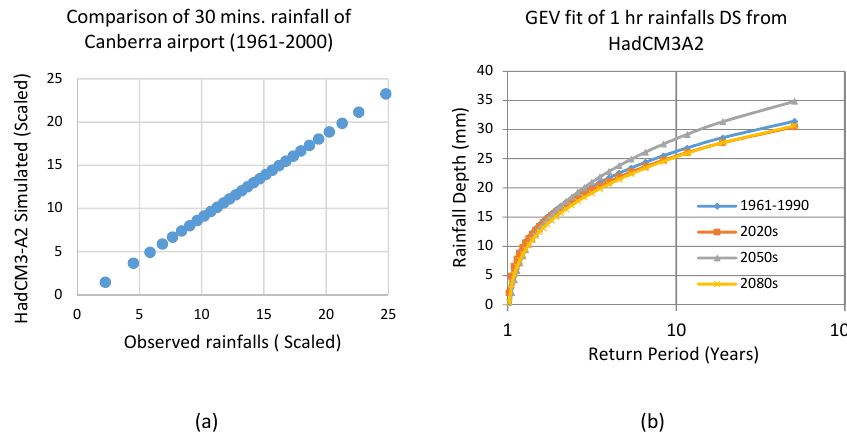
Figure 4. Evaluation of sub daily rainfalls. (a) Comparison 30min AM rainfalls (scaling of observed AM daily rainfalls and scaling of AM daily rainfall by HadCM3-A2) and (b) probability plots of 1-hour annual maximum rainfalls estimated from scaling daily annual maximum rainfalls from HadCM3-A2 scenario.